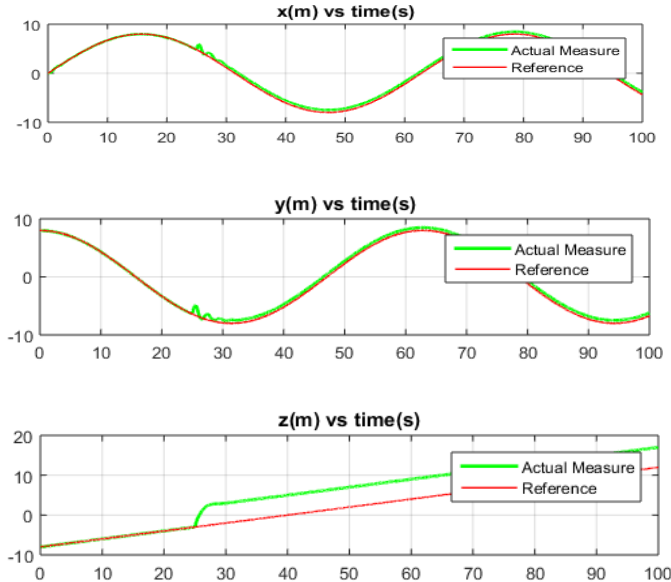
Figure 10. Position responses derived using SMC control